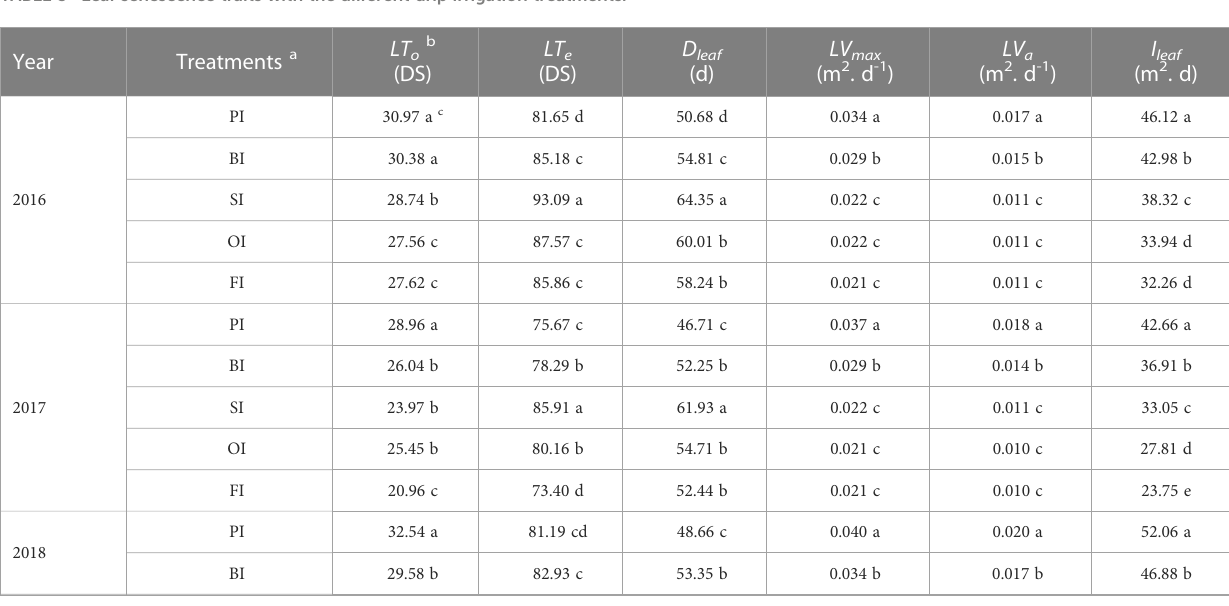
TABLE 3 Leaf senescence traits with the different drip irrigation treatments.